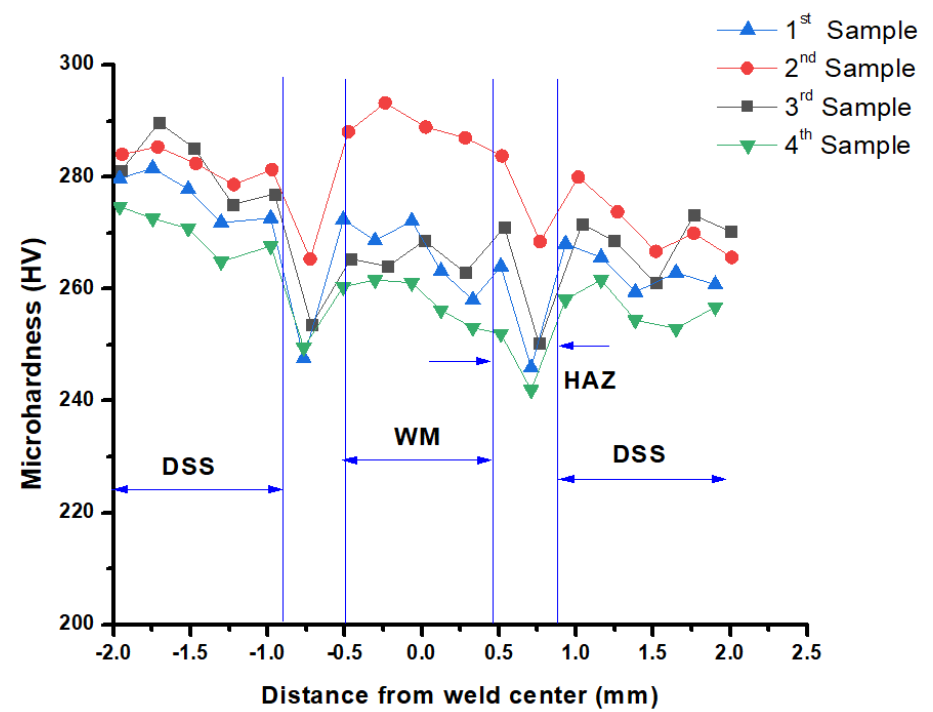
Figure 5. Micro hardness of different samples.